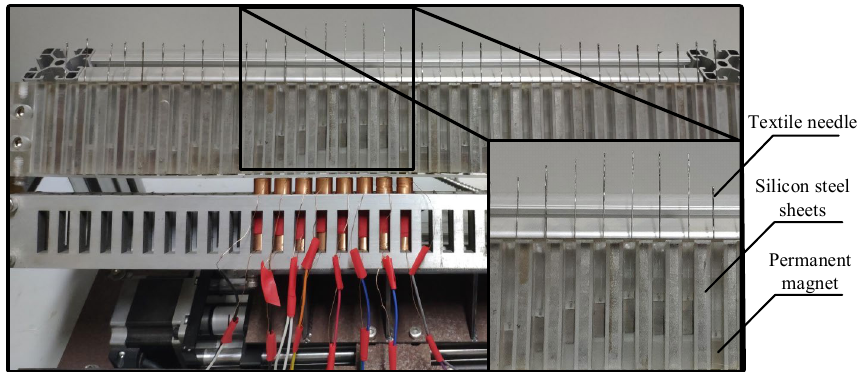
Figure 13. The driving effect of the hybrid maglev needle.